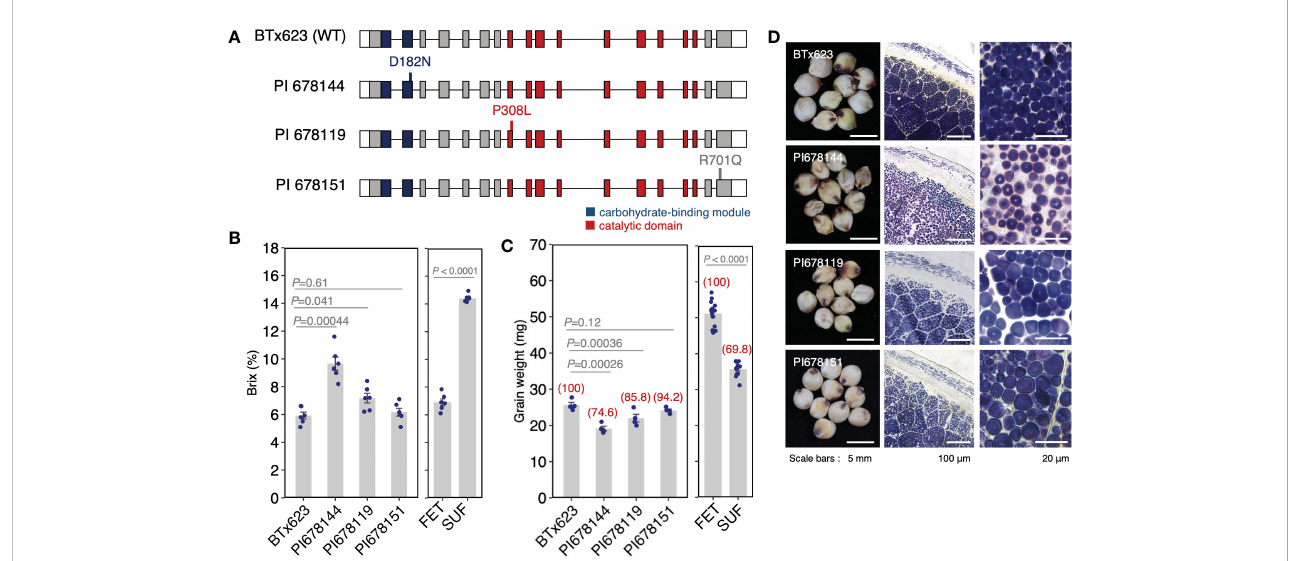
FIGURE 6 Novel sugary mutants of sorghum. (A) The position of the mutation in SbSu for each mutant. (B , C) Comparison of Brix values (C) and grain weight (D) of the mutants. In panel (C) red numbers on each bar with parentheses indicate the relative ratio of grain weight against wild-type. Data for FET and SUF are the same as in Figure 1 M, N. (D) Cross sections of seeds of SbSu mutants induced by EMS (see Materials and